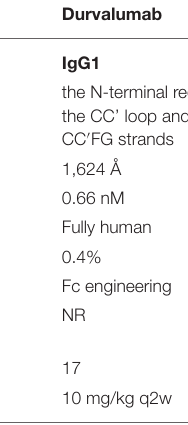
TABLE 2 | Comparison of the different PD-1/PD-L1 inhibitors.